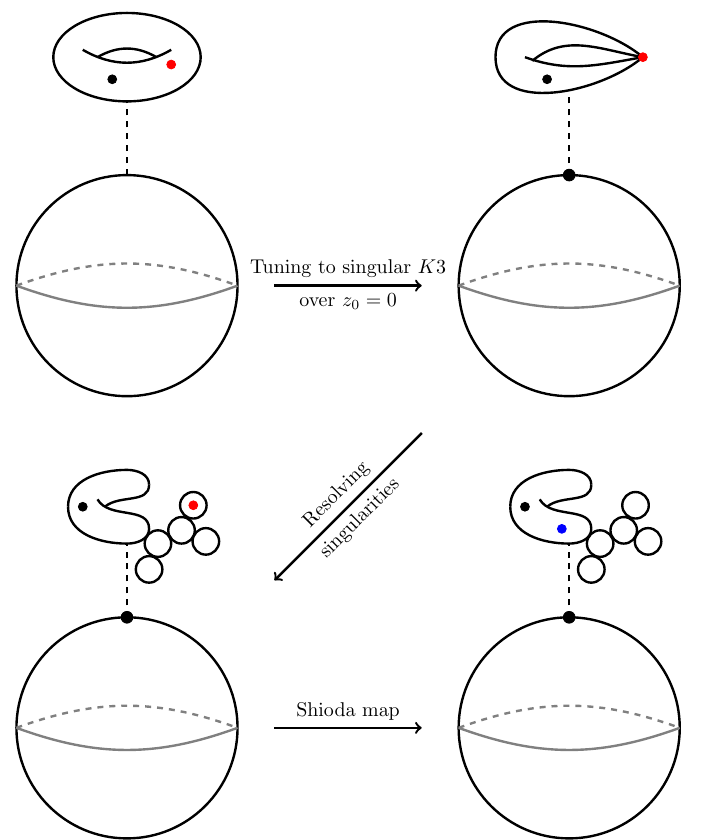
Figure 4 . The (cid:12)bration of the torus over P 1 (top left) turns via tuning into a singular K 3 E manifold (top right). Resolution of the singularity generates (cid:12)ve P 1 s with SO(10) intersections (bottom left); after the Shioda map has been carried out, the U(1) divisor intersects the a(cid:14)ne node P 1 (bottom 0